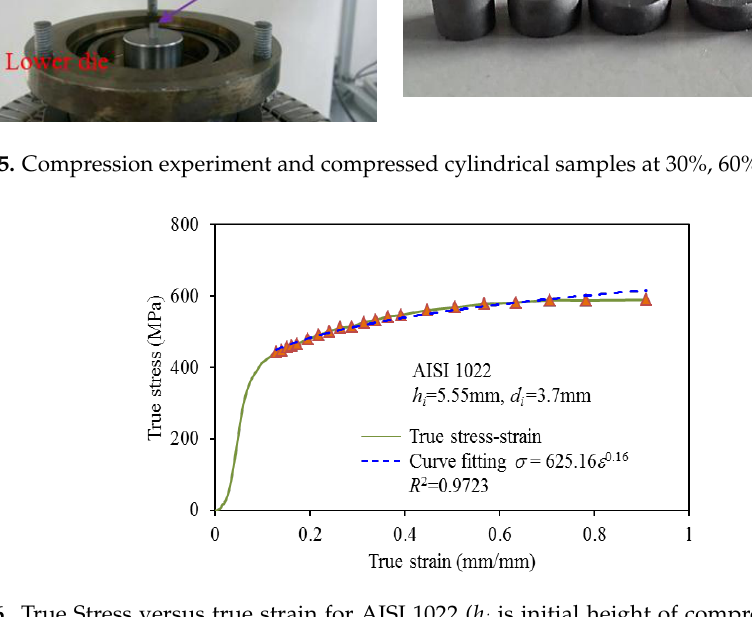
Figure 6. True Stress versus true strain for AISI 1022 ( h i is initial height of compressed cylindrical sample, and d i is diameter).